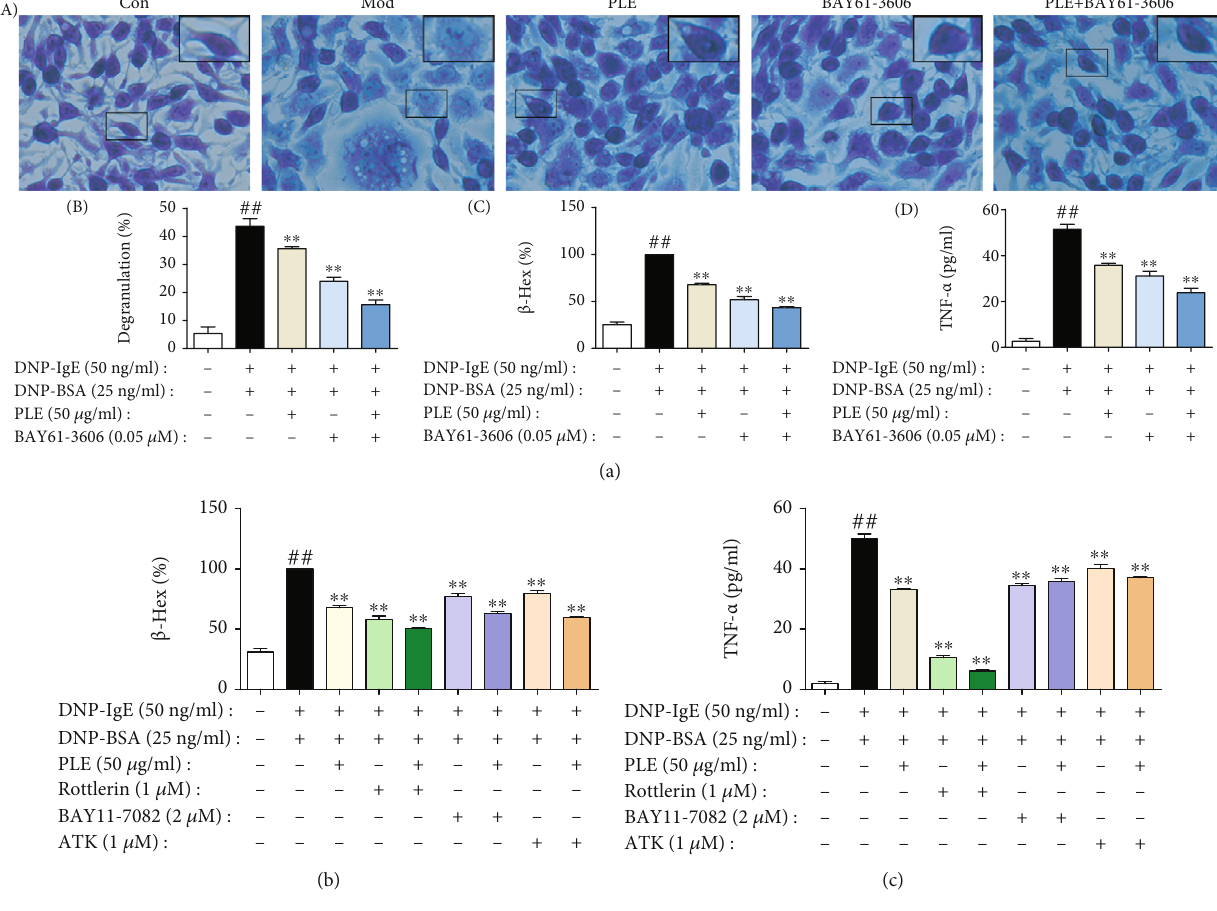
Figure 5: Veri fi cation that Syk, PKC, NF- κ B, and cPLA were related with PLE attenuated in fl ammation in DNP-IgE/BSA-induced RBL-2H3 2 cells. (a) (A) Images of RBL-2H3 cells stained by toluidine blue (magni fi cation, × 400), (B) the percent of degranulation (%) ( n = 3 ), (C) the release rate of β -Hex (%), and (D) the concentration of TNF- α in cells cotreated with PLE and Syk inhibitor ( n = 3 independent experiments). (b) The release rate of β -Hex and (c) production of TNF- α in cells cotreated with PLE and PKC, NF- κ B, or cPLA inhibitor ( n = 3 2 independent experiments). ## P < 0 : 01 vs. the control group; ∗ P < 0 : 05 and ∗∗ P < 0 : 01 vs. the model